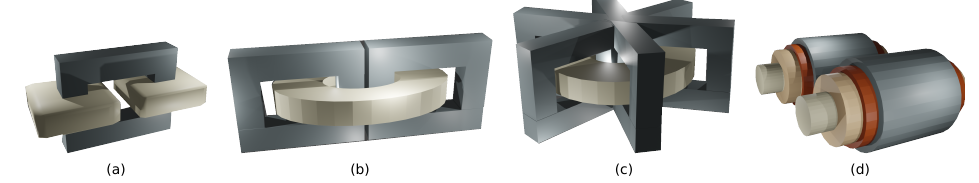
Figure 23. Transformer core geometries [130,140,141]: ( a ) core type, ( b ) shell type, ( c ) matrix type, and ( d )